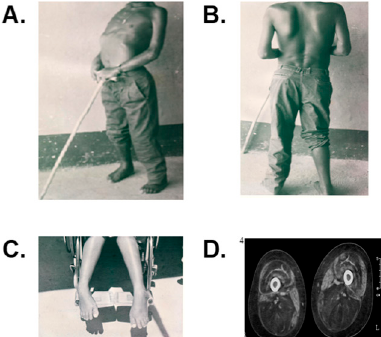
Figure 2. ( A ). Presence of severe generalized primary contractures of the elbows and lordosis shown in case 4, functional stage VI. ( B ). Winging scapula in case 4. ( C ). Presence of bilateral equinovarus foot in case 5, functional stage VII. ( D ). Case 4, functional stage VI, showing Mercuri grade IV affection with thigh proximal femur’s bilateral atrophy and a confluence of fatty infiltrated areas in the posterior, anterior, and the adductors muscular groups with unaffected gracilis and sartorius muscles.